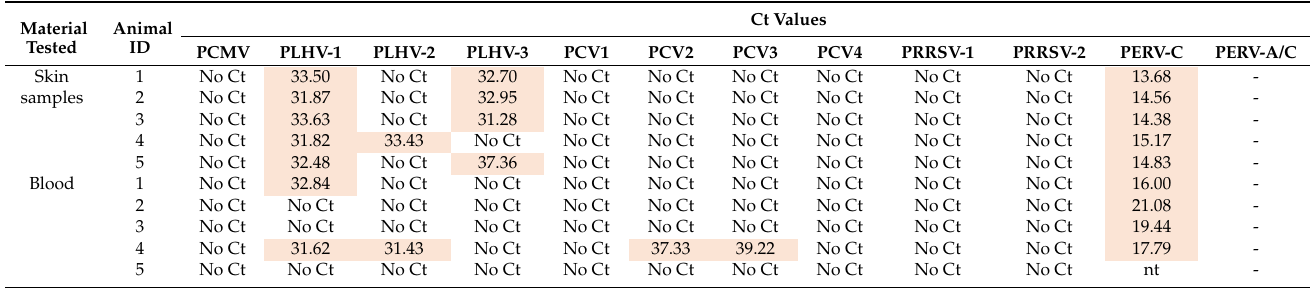
Table 3. Screening for porcine viruses in pigs with erythema